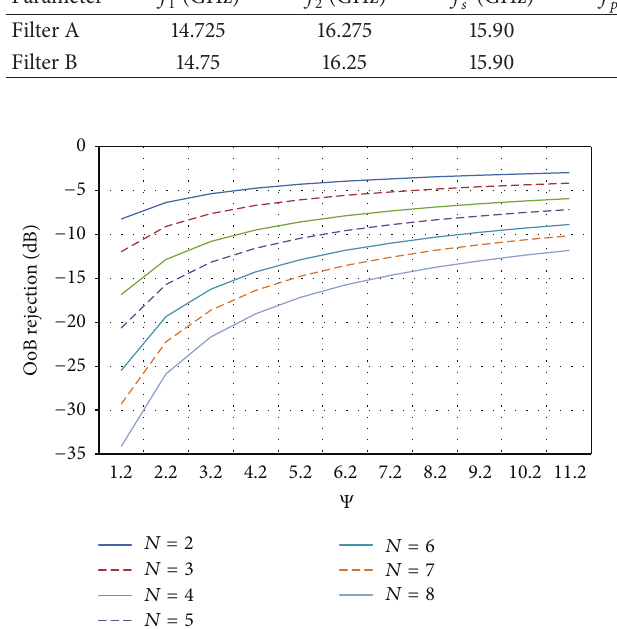
Figure 7: Out-of-band rejection (OoB) as a function of Ψ and 𝑁 . 0.911.11.21.31.4